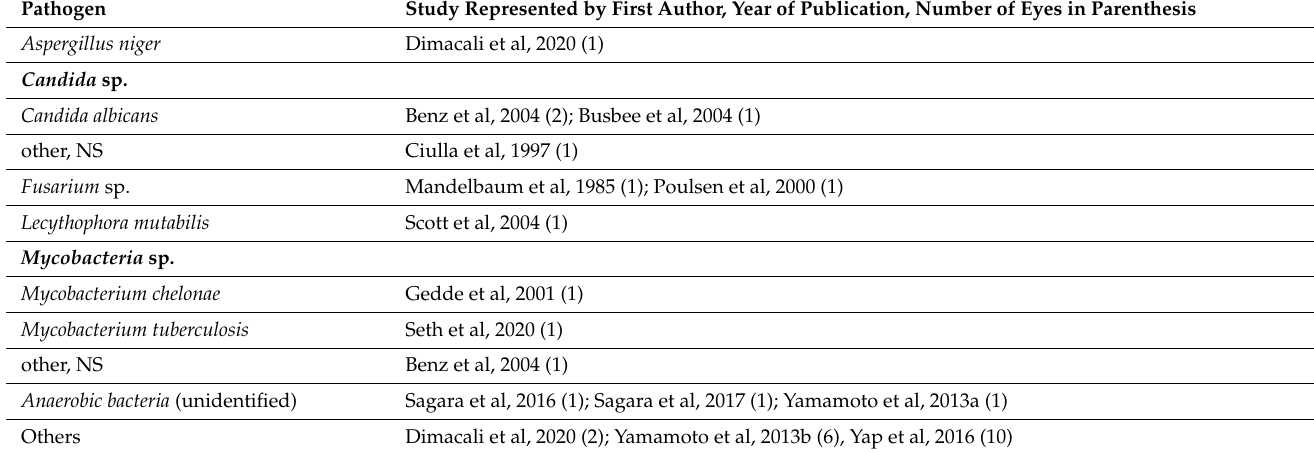
Table 3. Rare and uncommon pathogens associated with